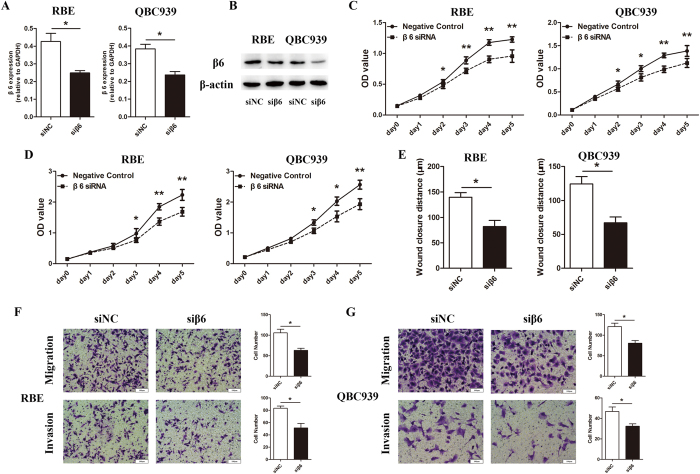
β6 silencing markedly decreased the proliferation, migration and invasion of cholangiocarcinoma cells.(A) Real-time PCR showed that integrin β6 expression was high in both RBE and QBC939 cells; β6 expression was significantly suppressed after β6-specific siRNA transfection. (B) Western blotting showed that β6 expression was significantly suppressed after β6 siRNA transfection in RBE and QBC939 cells at the protein level. (C) CCK8 assays revealed that silencing of β6 significantly decreased cell viability in RBE and QBC939 cells. (D) After transfection of β6 siRNA, MTT assays were conducted to evaluate the proliferation of RBE and QBC939 cells. (E) RBE and QBC939 cells transfected with β6 siRNA were used for wound-healing assays. (F,G) RBE (F) and QBC939 (G) cells transfected with β6 siRNA were used for Transwell migration assays and invasion assays. Five fields of cells in the lower chamber were counted (×200 magnification). Data represent the mean ± SD of three independent experiments. *P < 0.05; **P < 0.01.